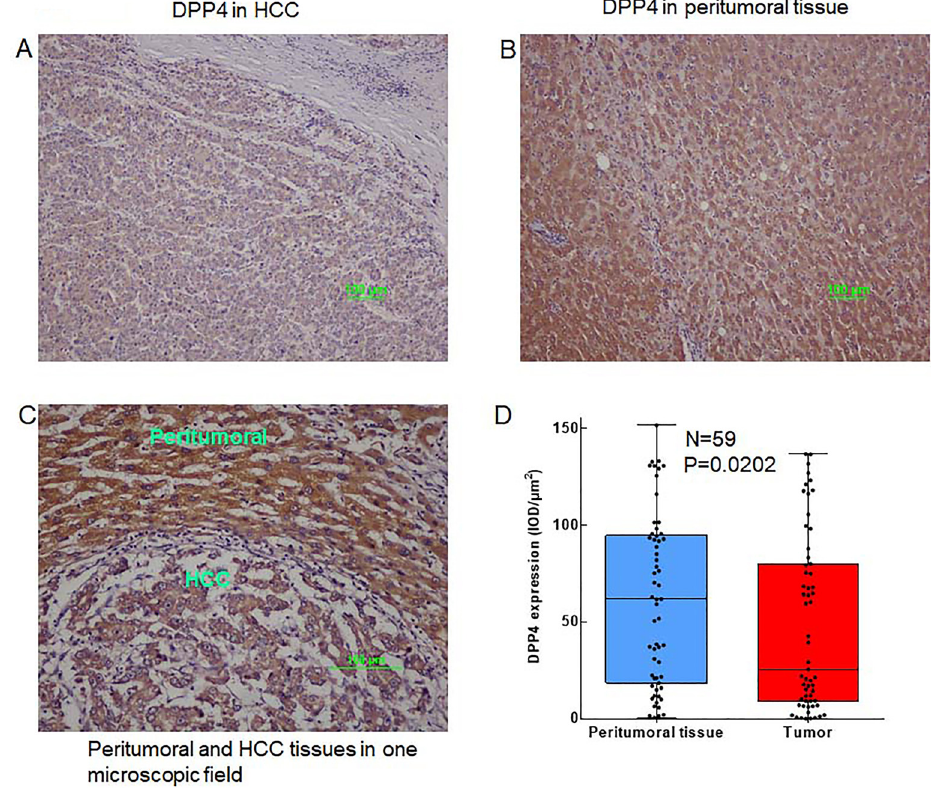
Figure 1. Expression of dipeptidyl peptidase 4 (DPP4) in ( A ) hepatocellular carcinoma (HCC) tissue, ( B ) paired peri-tumoral liver tissue, and ( C ) HCC tissues and peri-tumoral tissues in one microscopic fi eld ( (cid:1) 100, scale bar 100 m m). D , Box plot showing the expression level (IOD/ m m 2 ) of DPP4 in HCC tissue (n=59). Data are reported as median and interquartile range. P=0.0202, chi-squared